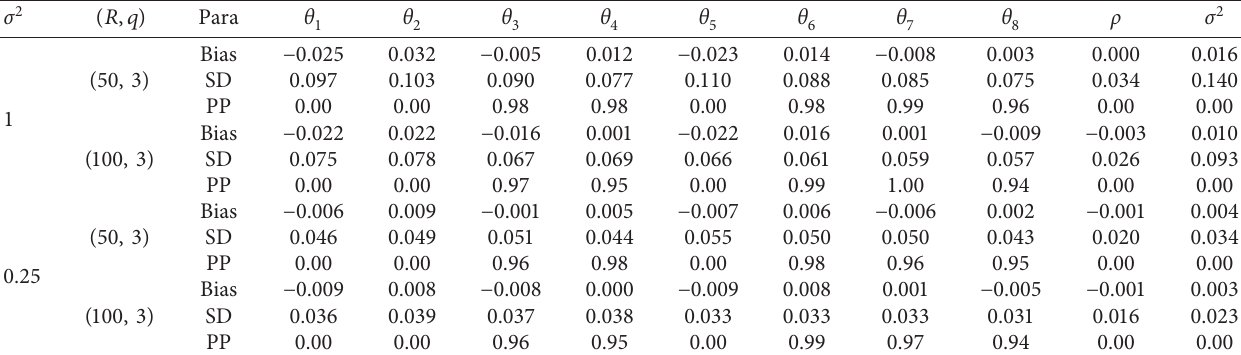
Table 1: Bayesian estimates of unknown parameters under different cases when ρ � 0 . 5 .